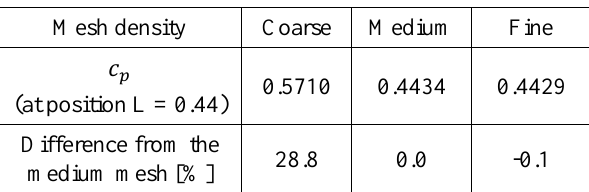
Table 2. Static pressure recovery factor depending on mesh